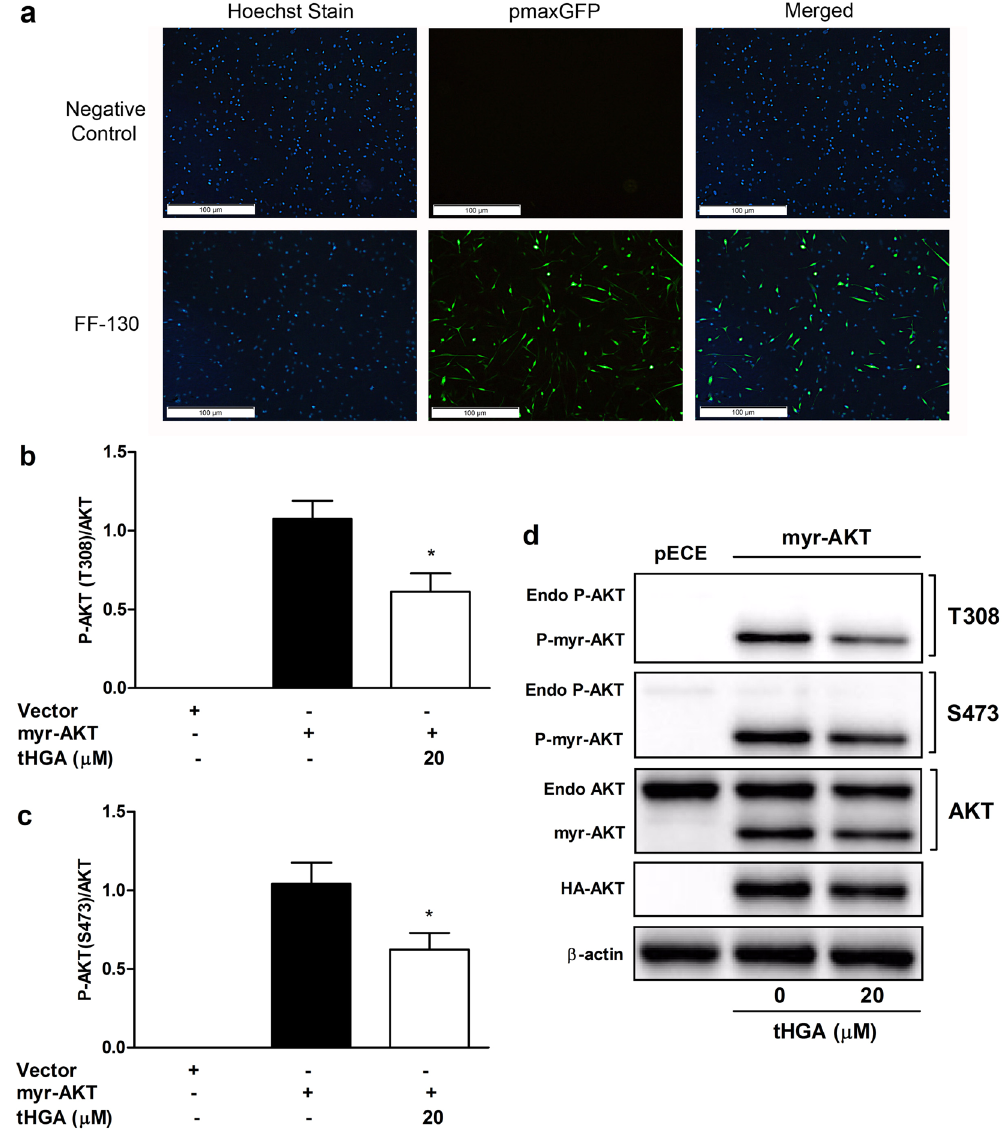
Figure 6. tHGA attenuates constitutively active AKT in hBSMCs. ( a ) hBSMCs were transfected with pmaxGFP with negative control (no program) or Nucleofection program FF-130. Transfected hBSMCs were seeded in complete media for 48 hours and then stained with Hoechst stain. Representative images of hBSMCs post transfection were depicted. ( b , c ) hBMSCs were transfected with pECE empty vector or myr-Akt and seeded in complete media for 24 hours prior to treatment. Transfected hBSMCs were then serum starved for 24 hours before treated with/without 20 µ M tHGA for 1 hour. Proteins were immunoblotted with respective antibodies and the protein bands were quantified by densitometry. Results of ( b ) phospho-AKT (Thr308) and ( c ) phospho-AKT (Ser473) were presented after normalization with total AKT. ( d ) Representative cropped blots for results ( b , c ) are depicted (full-length blots are presented in Supplementary Fig. S4). Results are presented as mean ± SEM of 3 independent experiments. * P < 0.05, ** P < 0.01 and *** P < 0.001, significantly different from growth factor induced-hBSMCs. Endo: